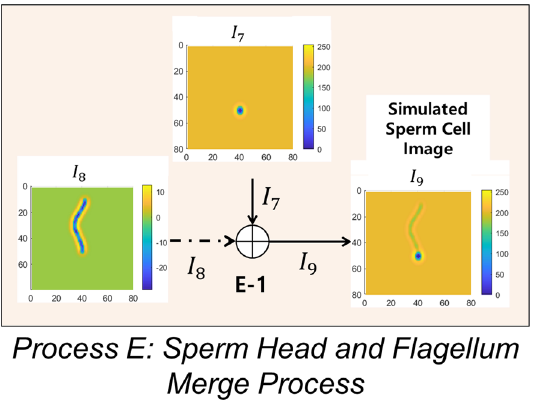
Figure 10. Diagram of sperm head and flagellum image merging process. Images I 7 and I 8 are the inputs. The output is the simulated image of sperm cell I 9 . I 7 and I 8 are added to generate I 9 (Process